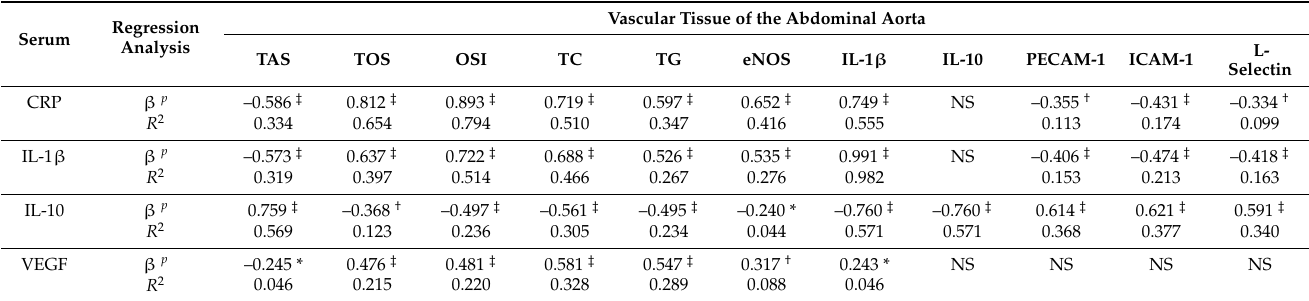
Table 9. Mutual relationships between the investigated parameters in the vascular tissue of the abdominal aorta and serum 3 .